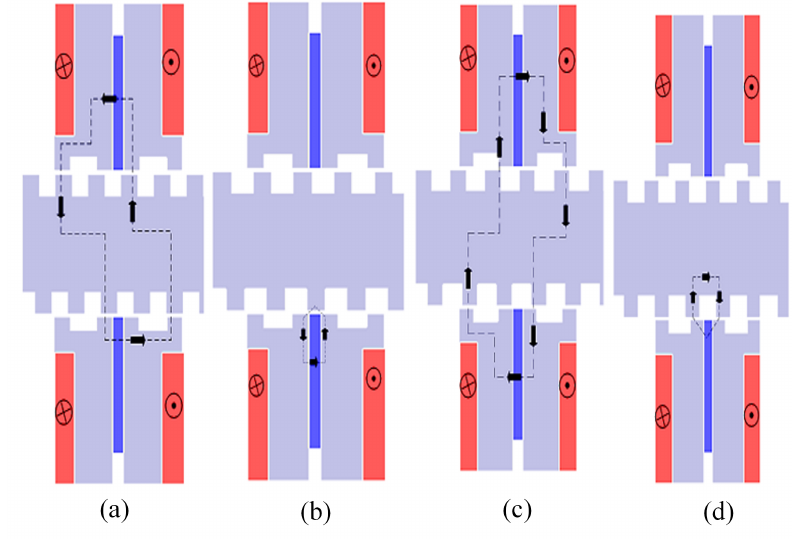
Figure 3. ( a ) Position 1, ( b ) Position 2, ( c ) Position 3, ( d ) Position